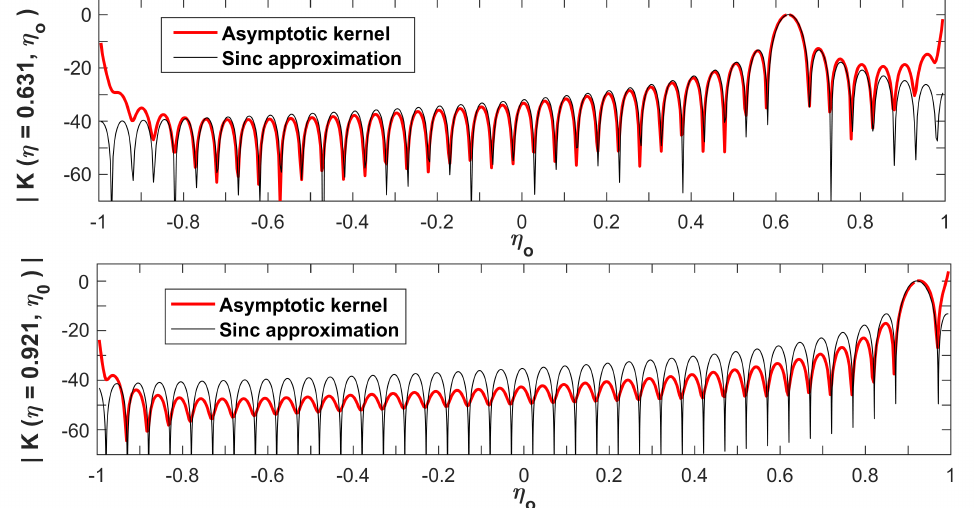
Figure 5. Behavior of | K ( η o ) | in dB for η = 0.631 ( x = 7.5 λ ) and η = 0.921 ( x = 15 λ ). The diagrams refer to the configuration a = 10 λ ( η ( a ) = 0.78), z o = 5 λ